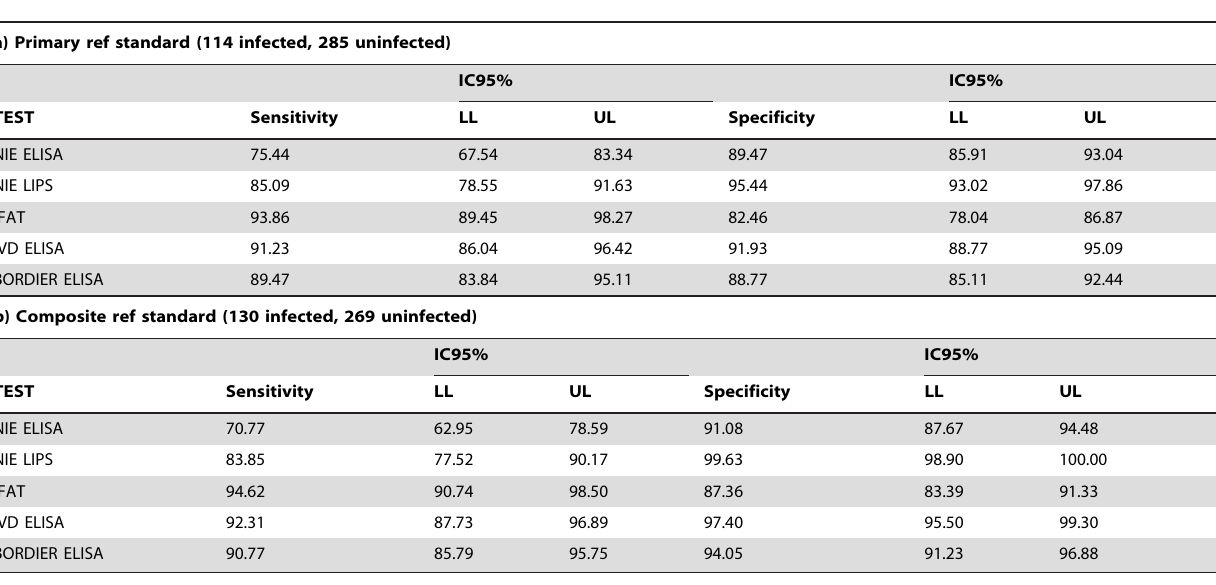
Table 4. Test accuracy on the whole study